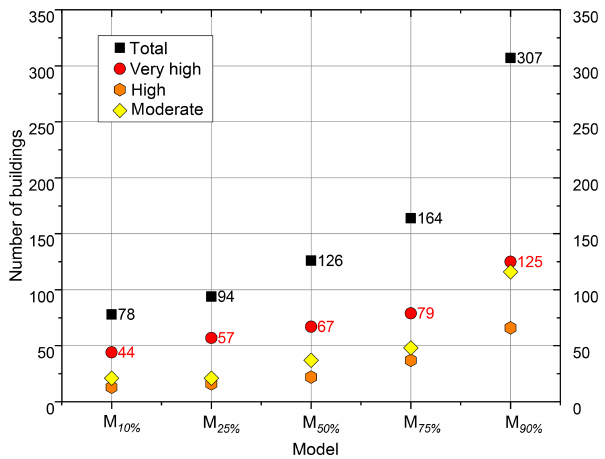
Figure 6. The number of affected buildings in each hazard class for 2D HD model results using five discharge percentiles. Table 3. Scenarios of multi-model combinations based on ex- ceedance